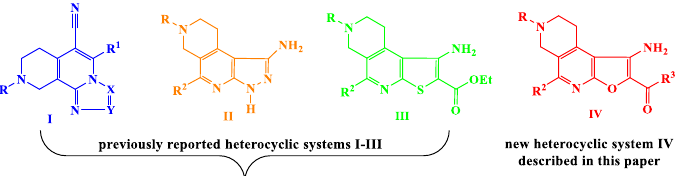
Figure 1. The general structures of previously I – III and new IV synthesized compounds.